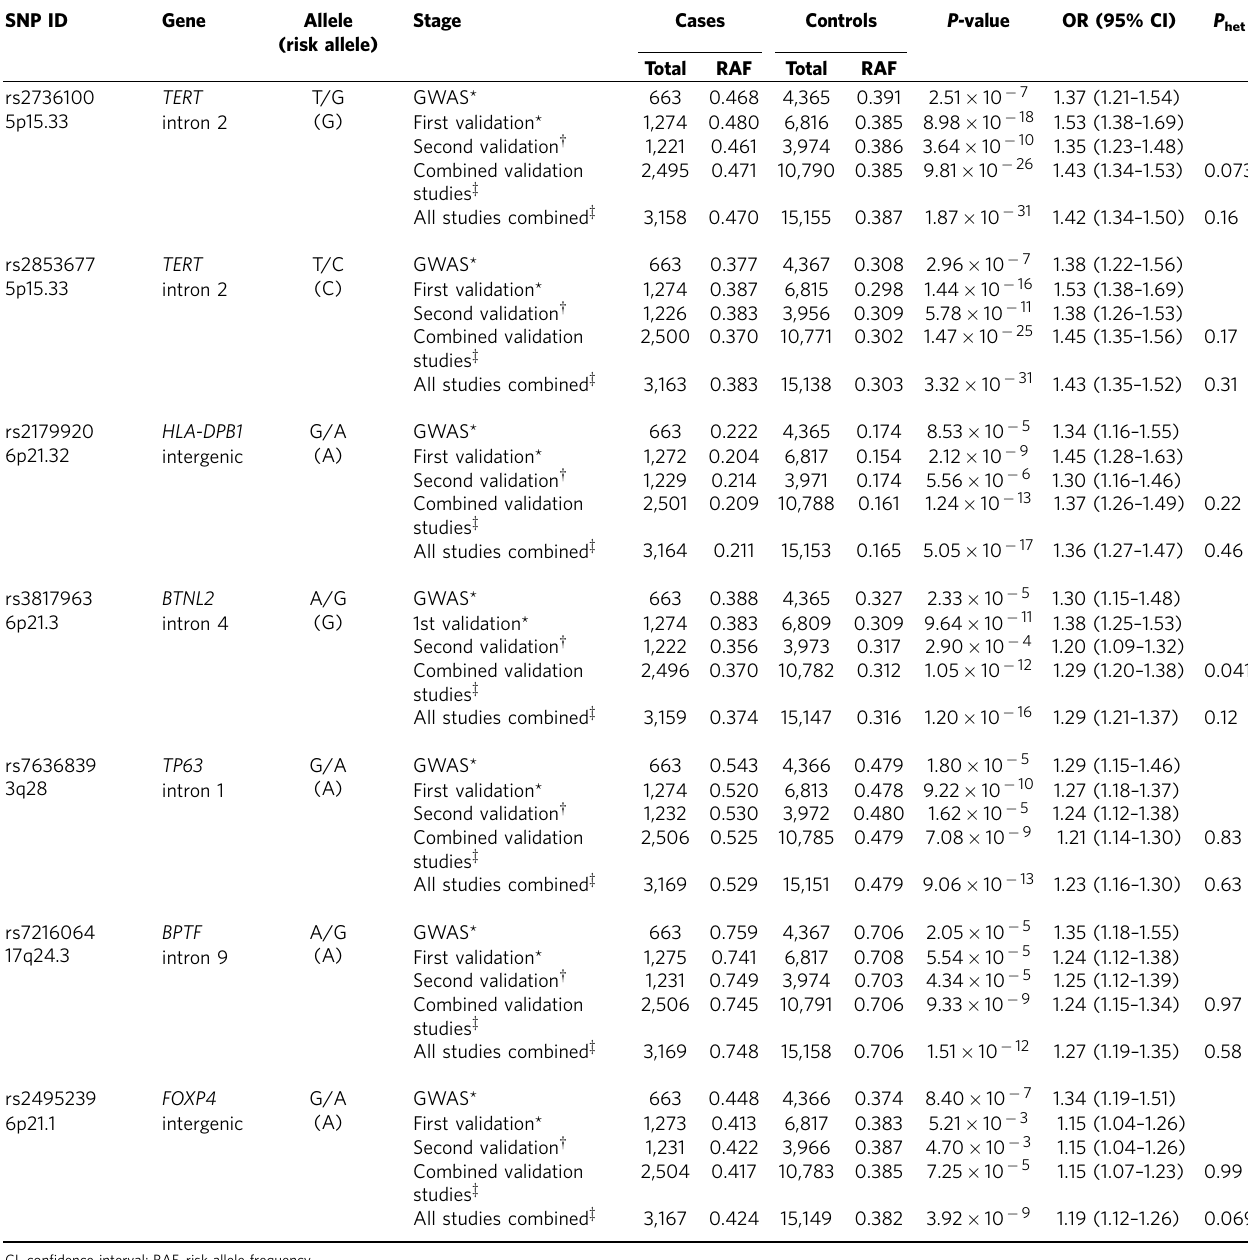
Table 1 | Associations of seven SNPs with the risk of LADC with EGFR mutation.